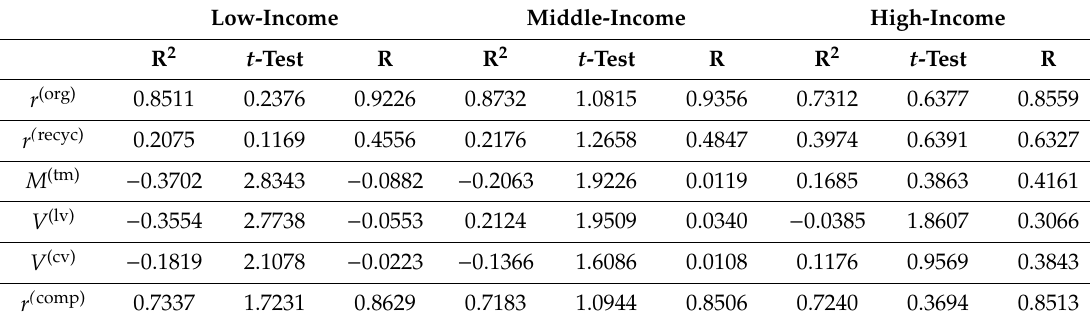
Table 7. The statistics for the three income